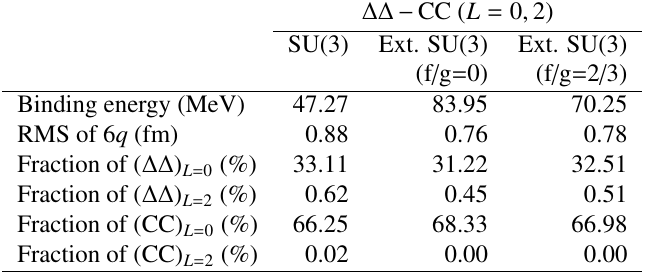
Table 1. Binding energy, root-mean-square radius (RMS), and fraction of each channel in d (cid:3)